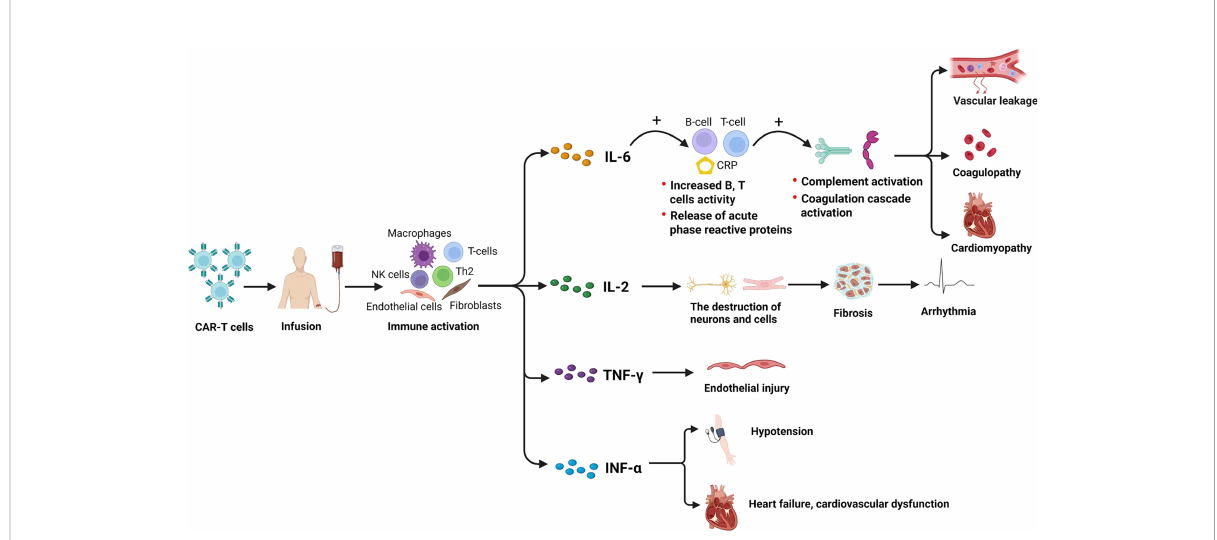
FIGURE 6 Potential cytokine-related mechanisms underlying the CV effects induced by CAR-T cell therapy. CV, cardiovascular; CAR-T cell, chimeric antigen receptor T cell. Created with